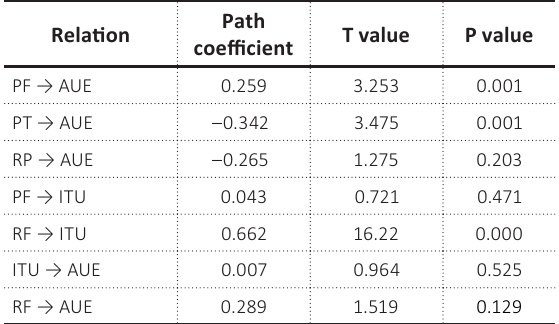
Table 5. Bootstrapping and the PLS path